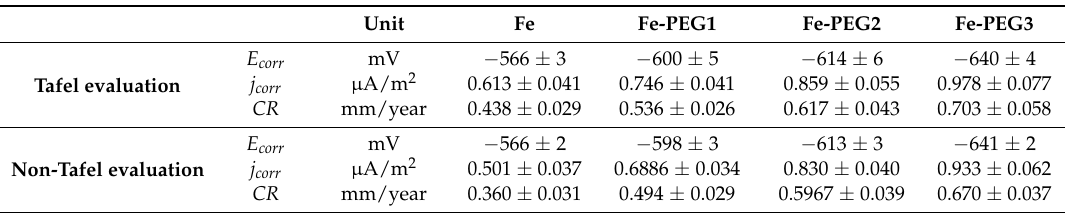
Table 5. Values of E corr , j corr , and CR for the uncoated Fe sample and samples with PEG film evaluated for the Tafel and non-Tafel behavior of potentiodynamic polarization curves.